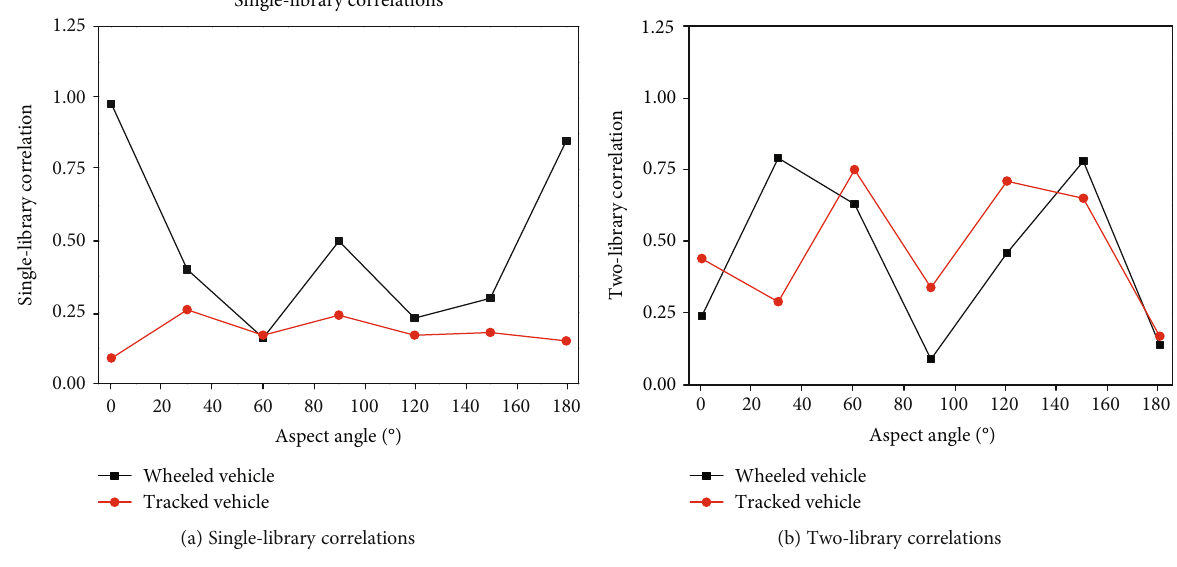
Figure 10: Single and two aspects of library correlations for wheeled and tracked vehicles RS.